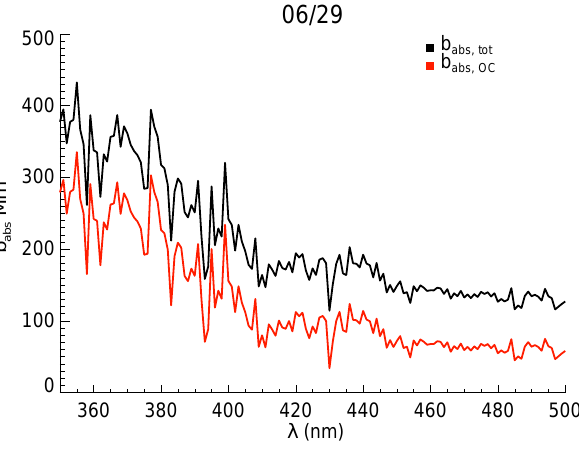
Fig. 6. Spectral b abs,OC ,λ calculated from b abs ,λ using methods outlined in Arola et al. (2011) for 17 April. Negative values of b abs,OC ,λ around the sharp dips in the total b abs ,λ curve were re- moved due to their unphysical nature for the AAE OA calculation.